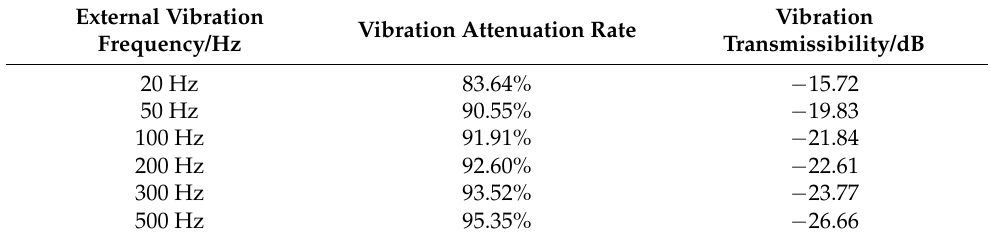
Table 11. Vibration attenuation rate and vibration transmission